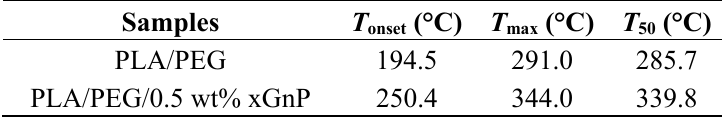
Table 2. Thermal degradation temperature of PLA/PEG and PLA/PEG/xGnP nanocomposite.